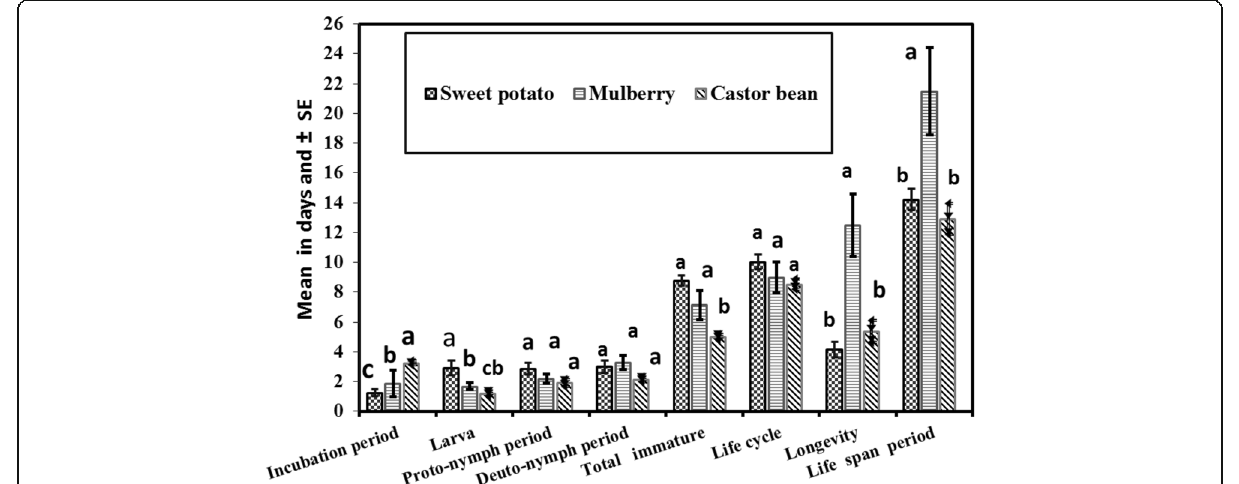
Fig.3 Effect different food types on biological aspects of Tetranychus urticae